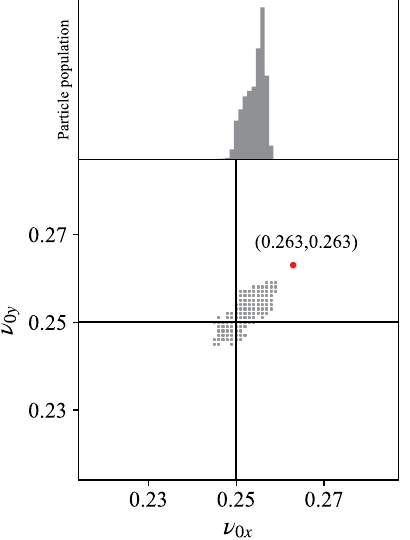
FIG. 10. Incoherent tune spread of a Gaussian beam at ν 0 x ¼ ν ¼ 0 . 263 (red dot) where the severe coherent envelope 0 y instability is expected. The conditions of the PIC simulation and Fourier analysis are the same as adopted in Fig. 9 (except for the operating bare